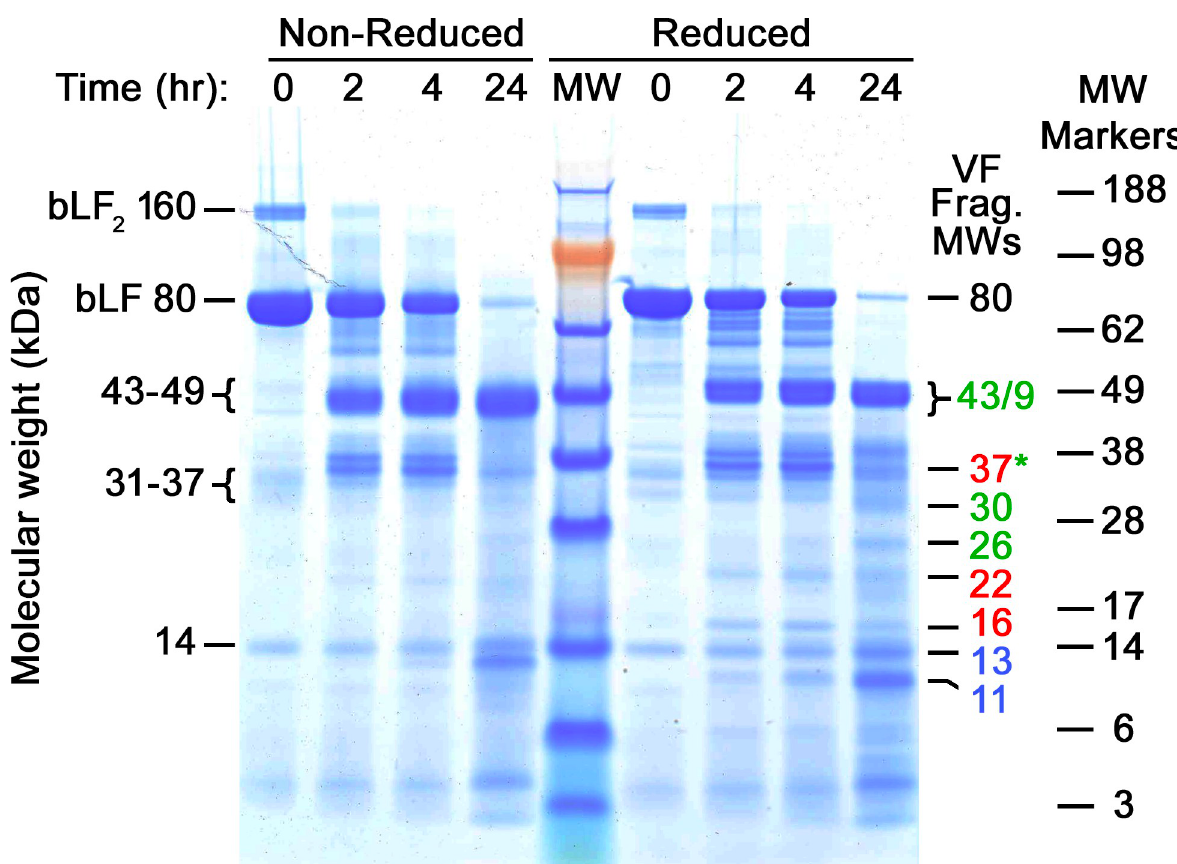
Fig 3. PAGE analysis of ex vivo VF digested MTbLF. Coomassie blue stained PAGE gel. Bands present in the original MTbLF are labeled on the left. Fragment molecular weight numbers are shown in the same color scheme as in Fig 2. The standard protein labels at far right correspond to the SeeBlue-Plus-2 standard ladder in the center lane (MW). The fragment bands obtained in this experiment were mostly identical to bands in Fig 2.